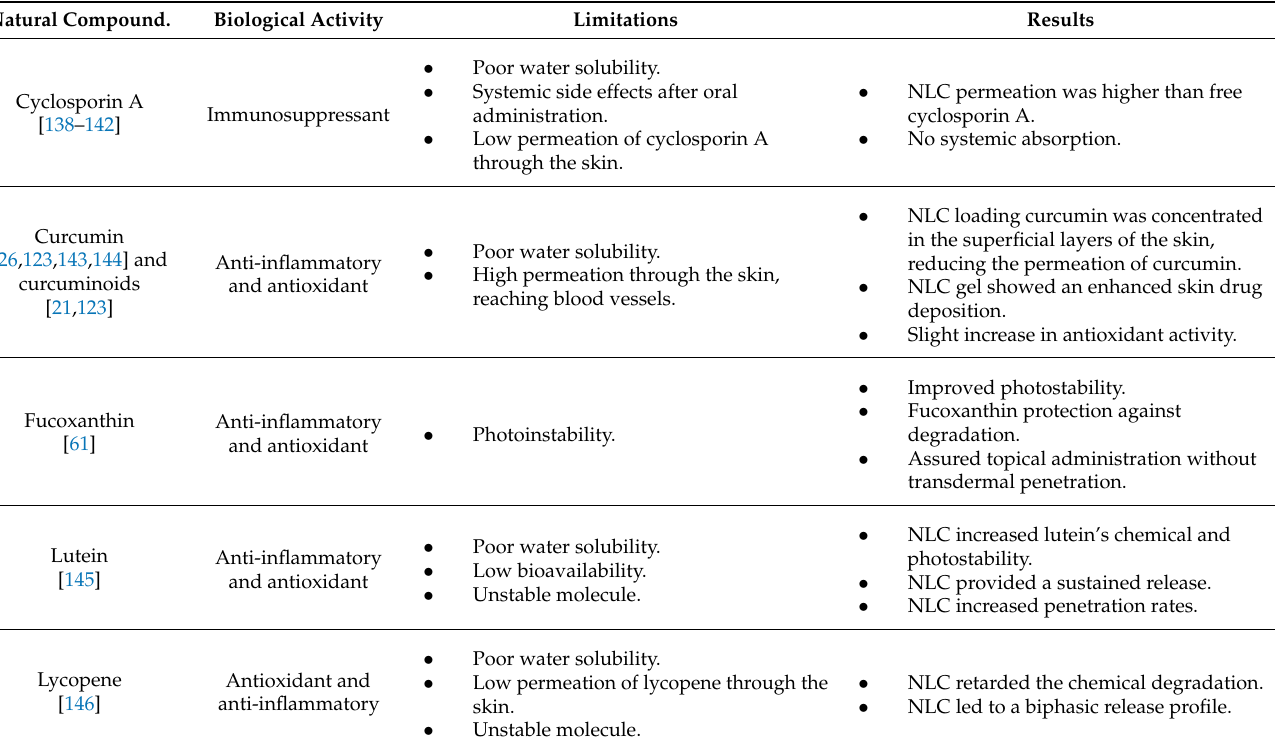
Table 2. Topical anti-inflammatory nanomedicines based on nanostructured lipid carriers containing natural substances. Natural